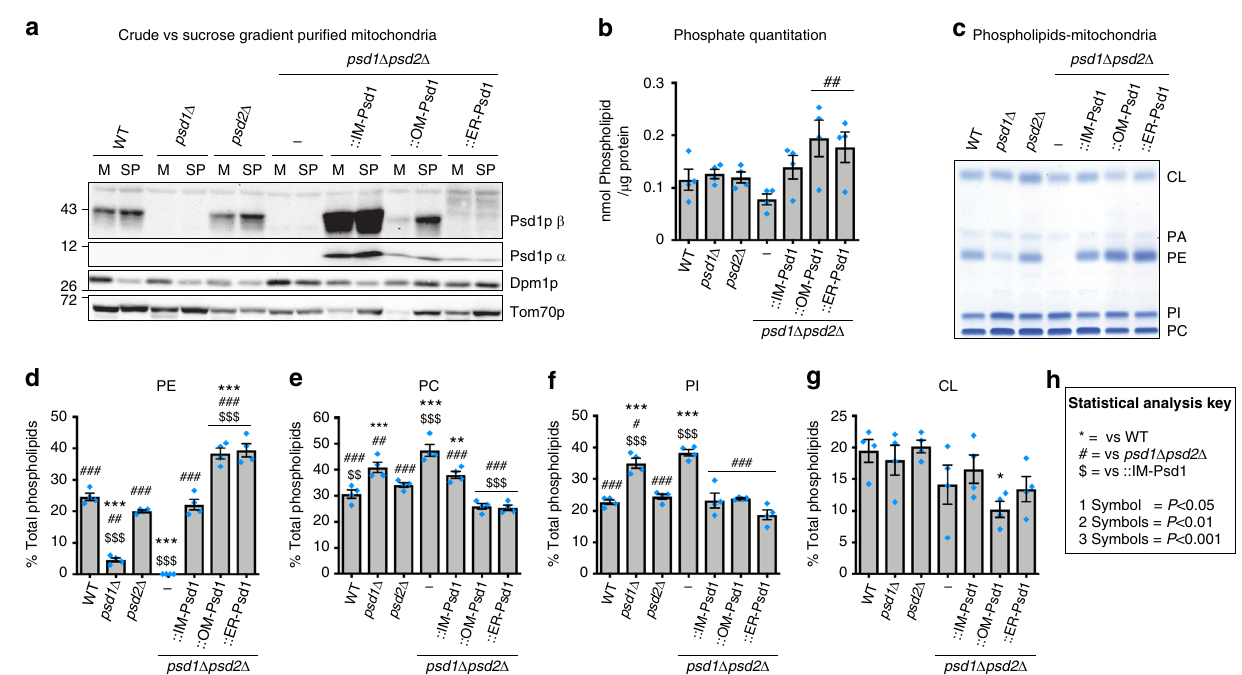
Fig. 3 PE is increased in mitochondria from OM-Psd1 and ER-Psd1. a Crude mitochondria (M) were puri fi ed using a two-step sucrose gradient (SP). Mitochondrial puri fi cation was monitored by using the mitochondrial marker Tom70 and the endosomal marker Dpm1. b Total phospholipid content/ mitochondrial protein (mean ± S.E.M., n = 4) in sucrose puri fi ed mitochondria. c Representative TLC plate of phospholipid extraction from sucrose puri fi ed mitochondria followed by visualization using molybdenum blue reagent. d – g Quantitation of phospholipid levels after separation by TLC and visualization by molybdenum blue staining (mean ± S.E.M., n = 4 biologically independent experiments). Statistical comparisons (ns, P > 0.05; 1 symbol P ≤ 0.05; 2 symbols P ≤ 0.01; 3 symbols P ≤ 0.001) were performed by one-way analysis of variance (ANOVA) with Tukey ’ s multiple comparison test. h Key for symbols used for statistical analysis interpretation when comparing samples versus WT (asterisk), psd1 Δ psd2 Δ (number sign), or IM-Psd1 (dollar